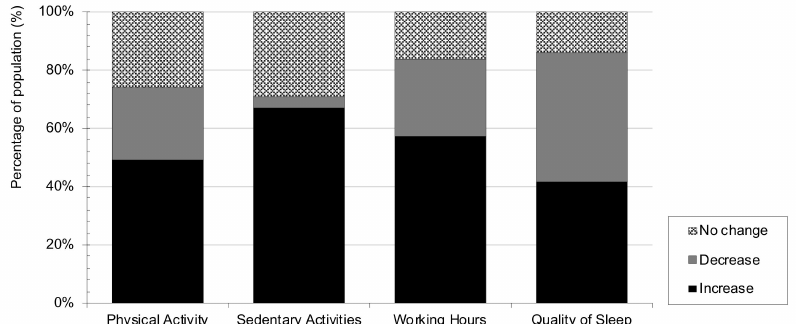
Figure 4. Percentage of population that reported changes in lifestyle habits during COVID-19